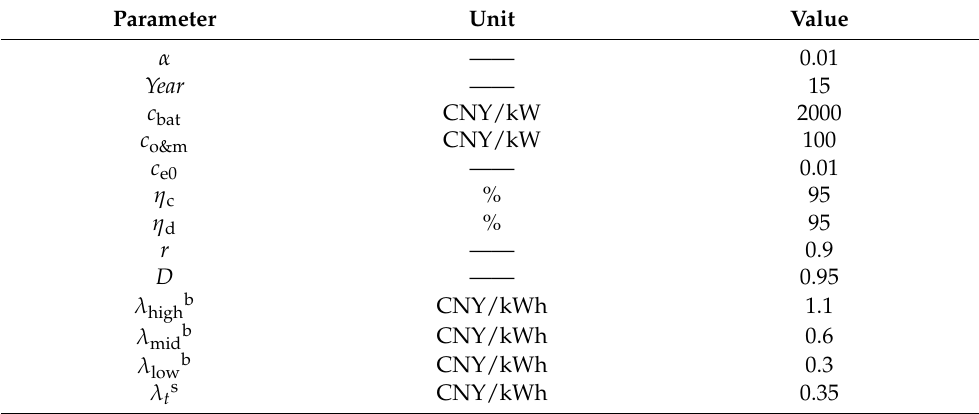
Table 2. Key parameters.